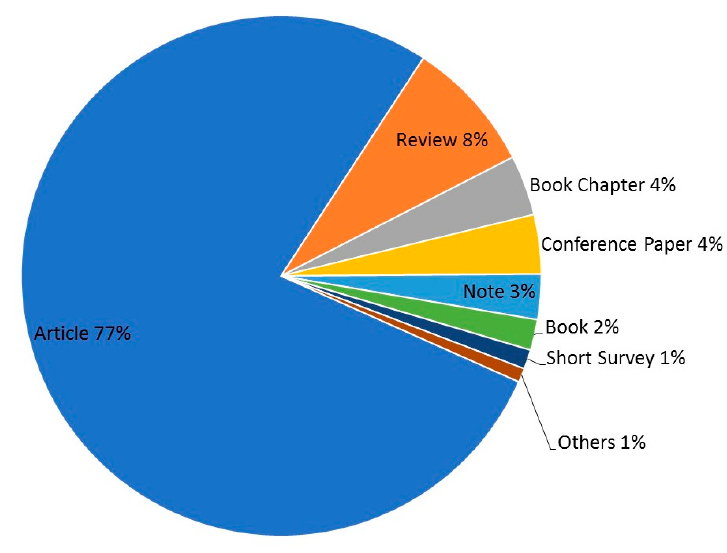
Figure 1. Distribution of worldwide research from 1970–2016 on labour relations by type of document.